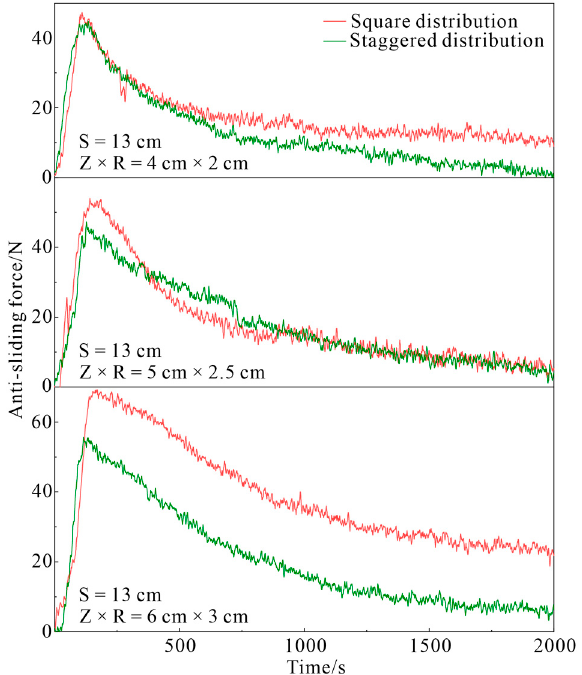
Figure 9. Effect of planting pattern of tap-like root system on anti-sliding force with constant plant spacing.